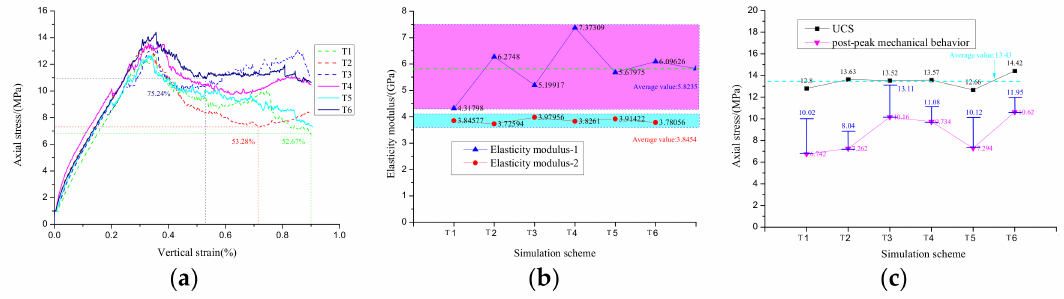
Figure 17. Mechanical characteristics of mineral circles in two positions: ( a ) stress–strain curve, ( b ) elastic modulus, ( c ) axial stress.